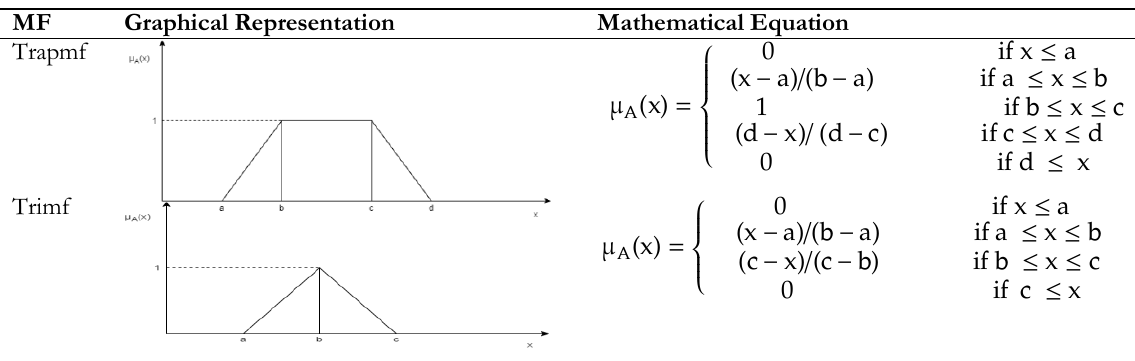
Table 3. Graphical and mathematical representation of